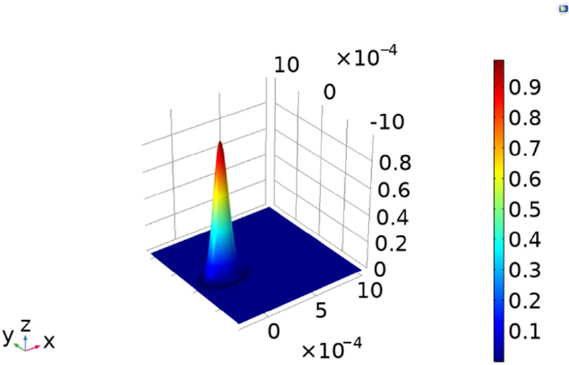
Figure 2. Temporal profile of Gaussian laser pulse with t 0 = 8 ns.